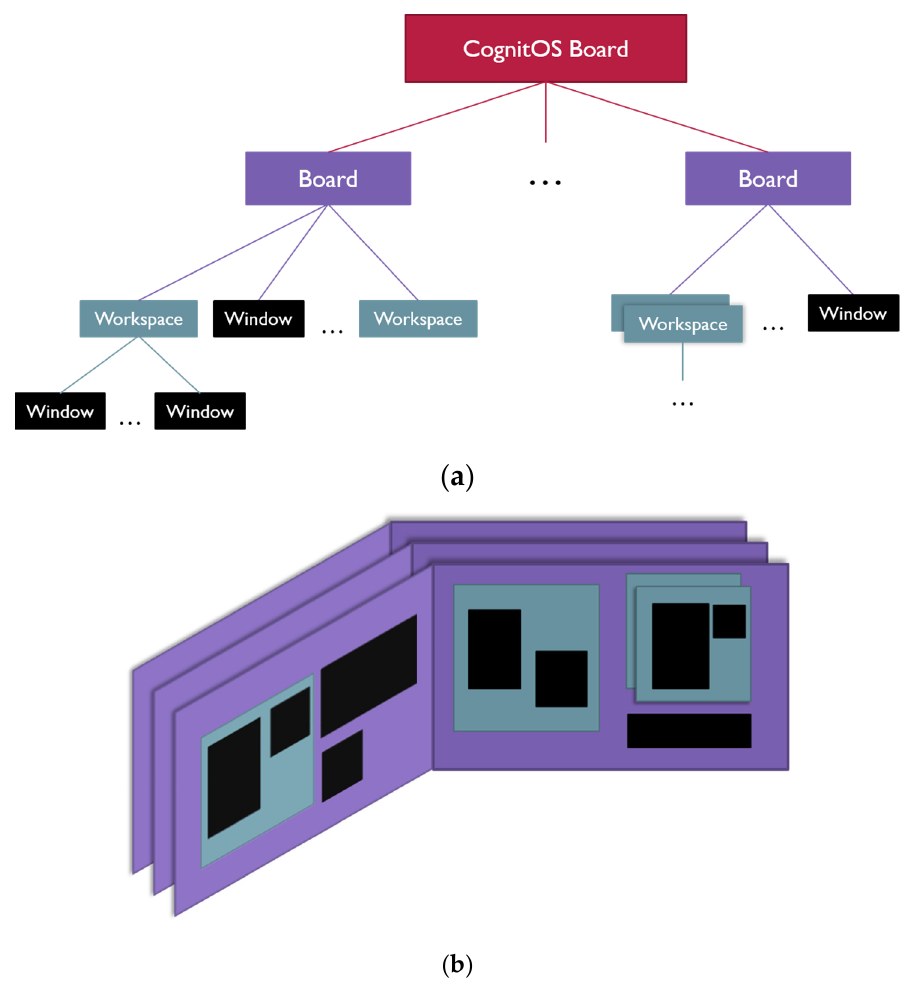
Figure 5. ( a ) Representation of the CognitOS Board components’ hierarchy. ( b ) Visualization of a sample system instantiation.